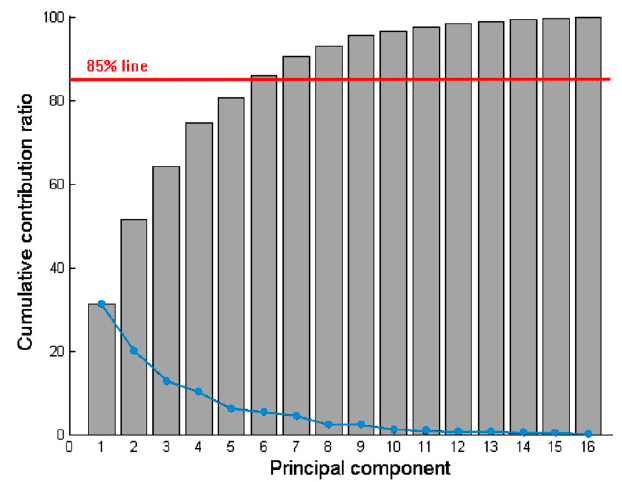
Figure 3. Scree plot of the cumulative contribution ratio versus principal components of the physicochemical properties.